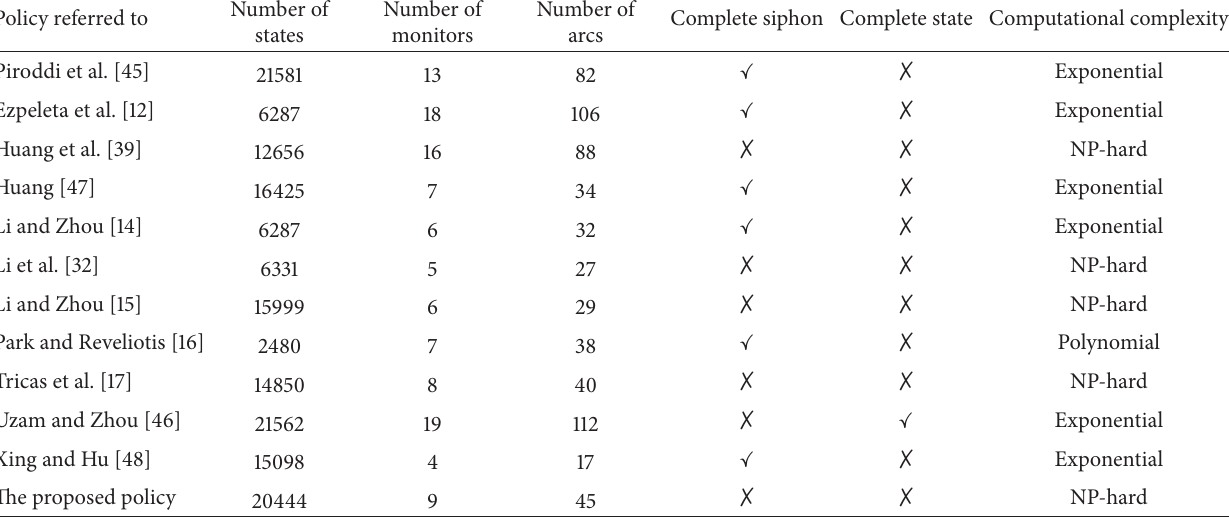
Table 3: Performance comparison of policies applied to the example in Figure